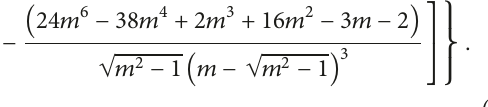
We plot diagram of the above pressure in Figure 8. They show that 𝑃 ∗ − > 0(< 0) in case 𝛿 = 0(0.9) for all values of Δ𝑇 ∗ > 0. Diagrams show that 𝑃 ∗ − is vanishing when 𝑚. It Δ𝑇 ∗ 󳨀→ 0. Also we plot diagram for 𝑃 ∗ − versus